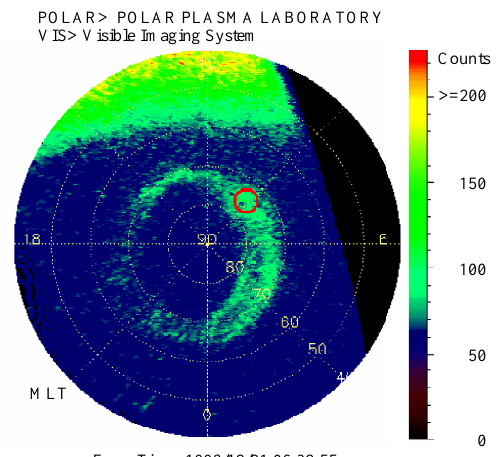
Fig. 2. Polar VIS ultraviolet image of the auroral oval in mag- netic latitude and magnetic local time coordinates. The field-of- view of the Longyearbyen all-sky camera at the indicated time (06:32:55 UT) is shown by the red circle.